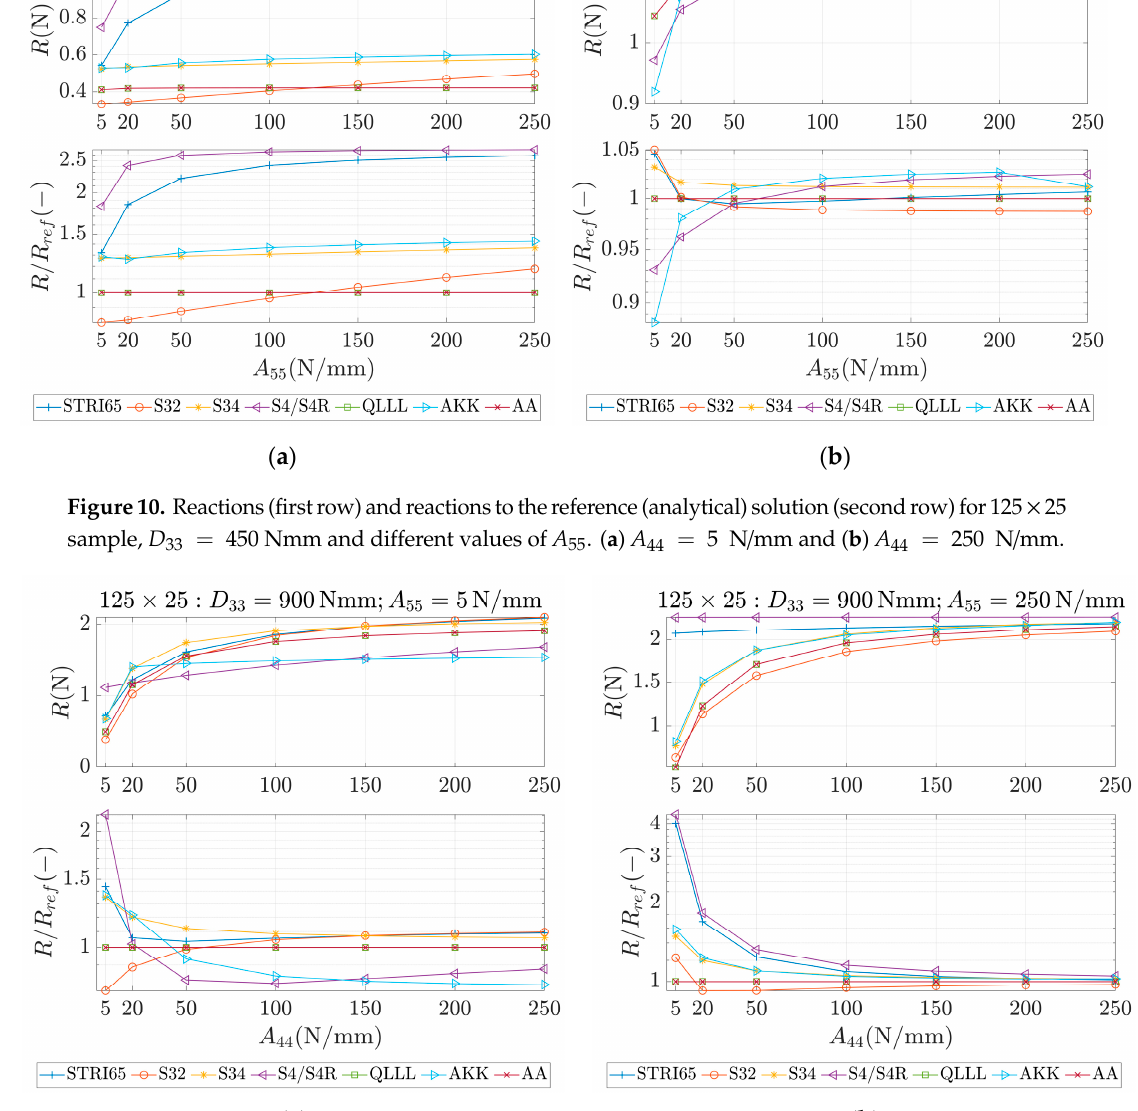
Figure 11. Reactions(firstrow)andreactionstothereference(analytical)solution(secondrow)for125 × 25 sample, D 33 = 900 Nmm and different values of A 44 . ( a ) A 55 = 5 N / mm and ( b ) A 55 = 250 N / mm.